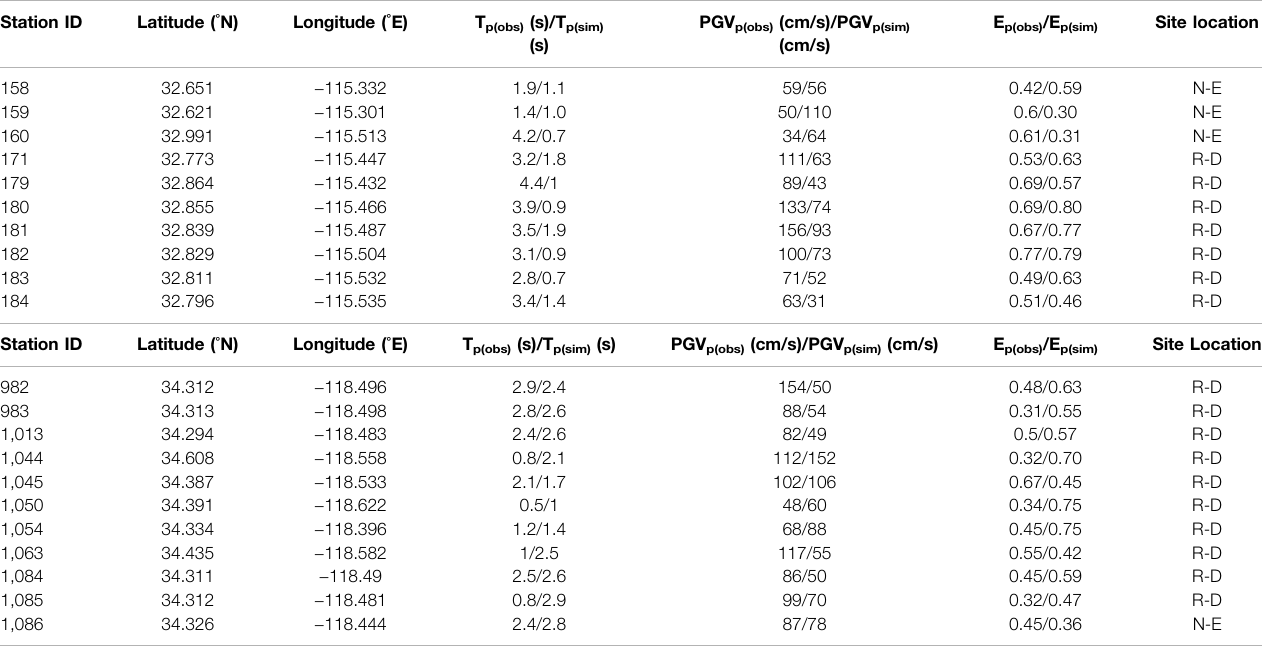
TABLE 3 | Station information and pulse indicator values. Station